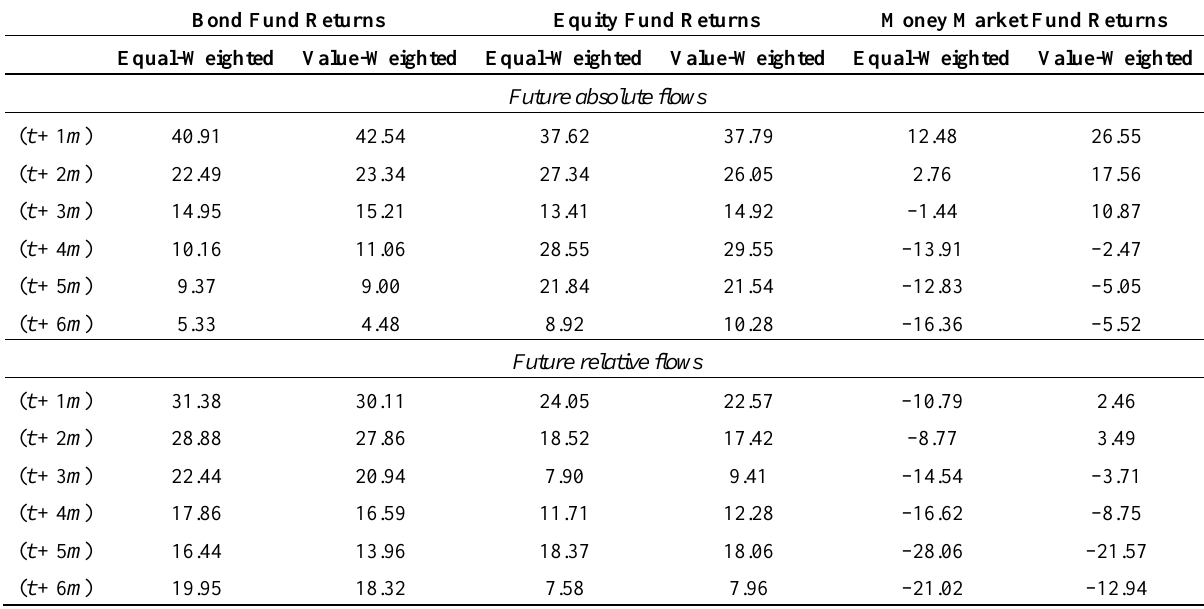
Table 4. Correlation coefficients between returns and future